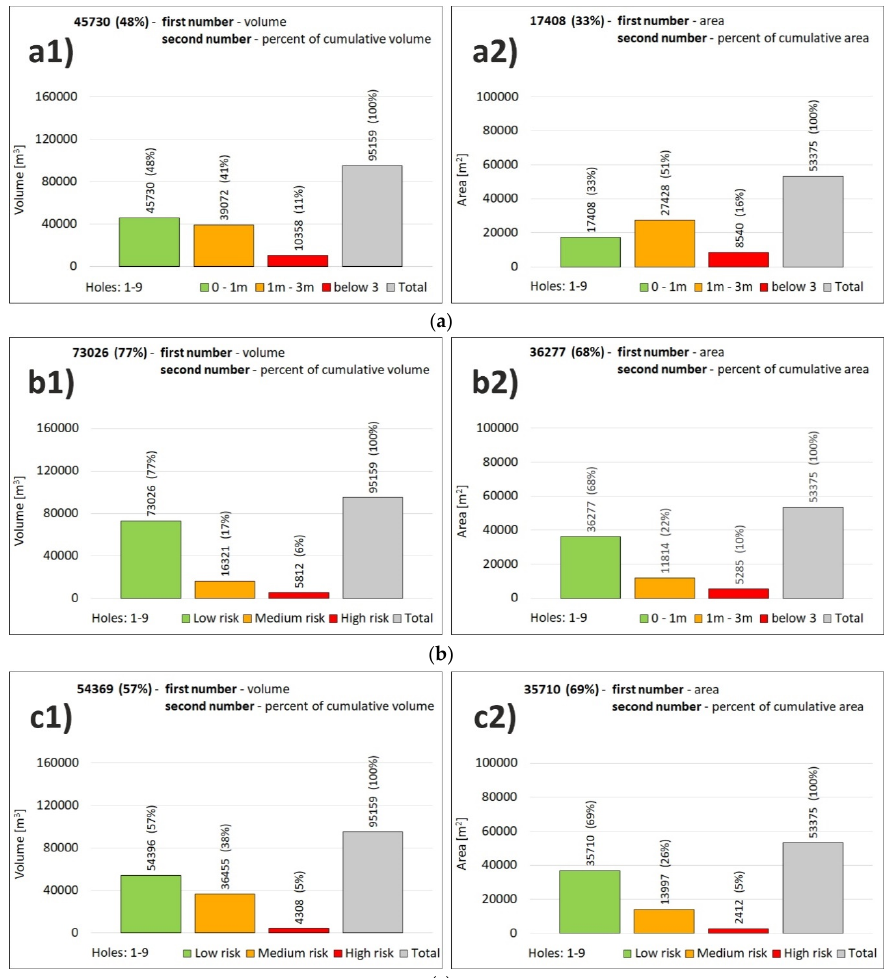
Figure 12. The sum of risk categories in the river bottom hazard map ( a ) classification by factor of pothole depth, ( b ) classification by factor of distance from structure of dam and threshold, ( c ) final map classification by combination of these 2 factors, ( a1 , b1 , c1 )—volume (m 3 ), ( a2 , b2 , c2 )—area (m 2 ).